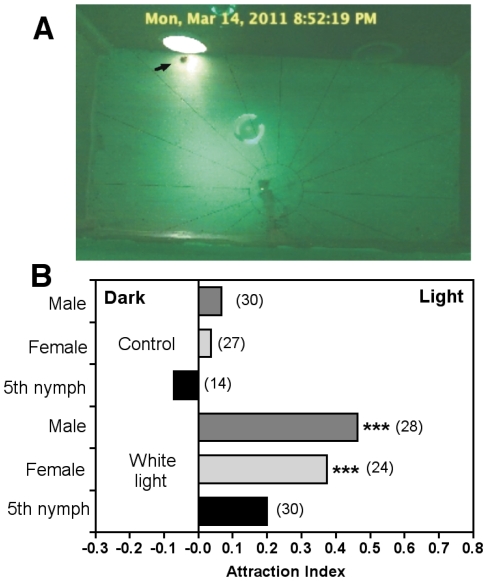
Attraction of T. dimidiata by white light in a dual-choice chamber.(A) Screen capture image of the chamber showing a triatomine about to enter the lit tunnel (arrow). (B) Attraction by light of adult male and female and 5th nymphal stage triatomines. The attraction index was calculated as described in the methods, with positive values indicating preference for the lit tunnel, negative values for the dark tunnel, and 0 indicates random distribution in both tunnels. Control experiments were carried out with both tunnels in the dark. *** indicates a significant difference with the control without lights (P<0.001) and numbers in parenthesis indicate the number of triatomines tested.